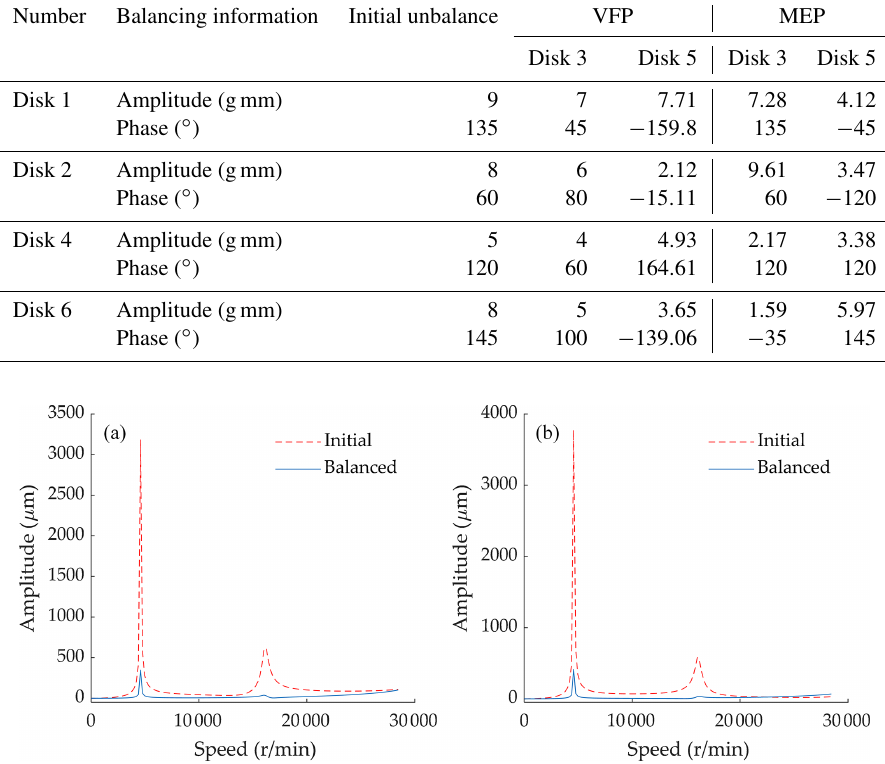
Table 1. Equivalent results of redundant disks in EPs.